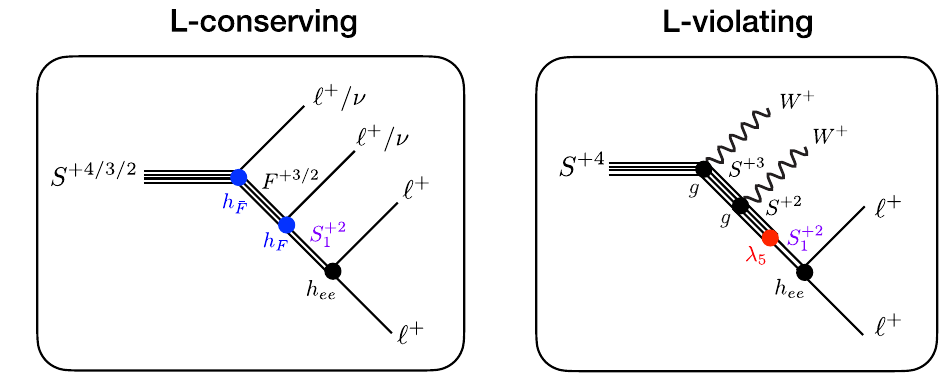
Fig. 2 Diagrams for possible decays for S + 4 , S + 3 and S + 2 . The same particle decays into both L = − 4 (left) and L = − 2 (right) final states, thus its lepton number is not fixed, once either λ × h ¯ is non-zero. For 5 or h F F simplicity, we assign the lepton number violation to λ 5 in the following. Observing both decay modes would be an experimental demonstration of lepton number